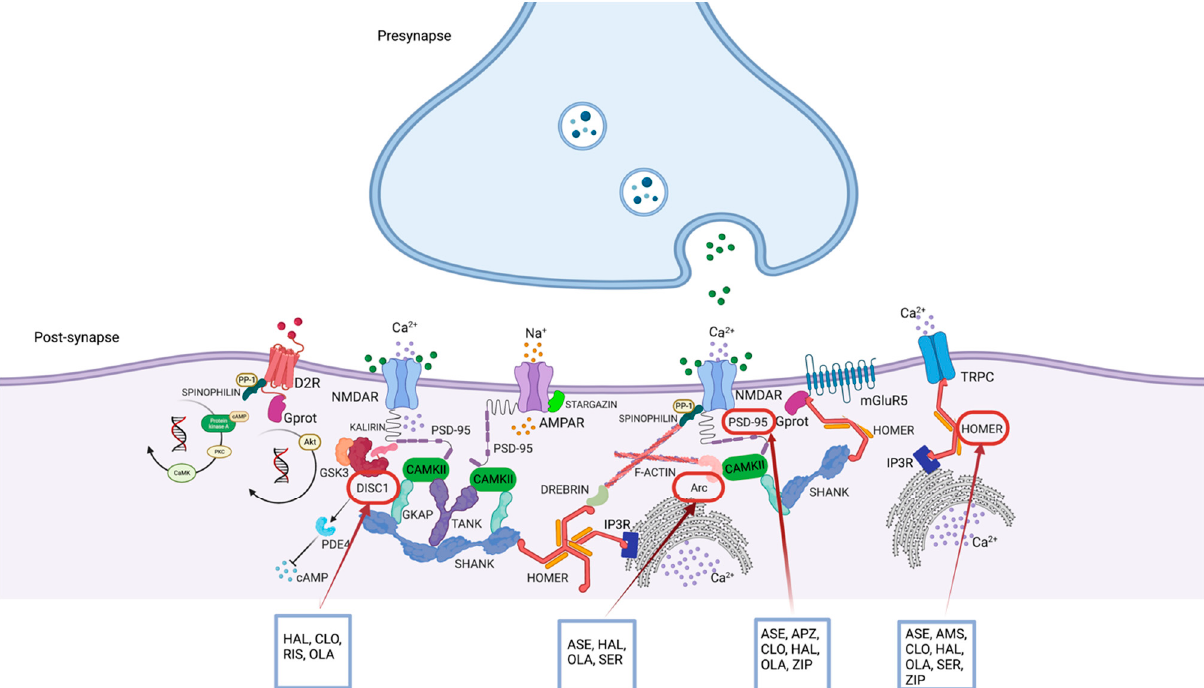
Figure 3. Main PSD proteins modulated by the receptor profile of different classes of antipsychotics. AMPAR = α -amino-3-hydroxy-5-methyl-4-isoxazolepropionic acid receptor; CAMKII = Calcium– calmodulin (CaM)-dependent protein kinase II; F-ACTIN = filamentous actin; GKAP = guanylate kinase-associated protein; GSK3 = Glycogen Synthase Kinase 3 Beta; IP3R = IP3 (inositol 1,4,5- trisphosphate) receptor; mGluR5 = metabotropic glutamate receptor 5; NMDAR = N-Methyl-D- aspartic acid receptor; SHANK = SH3 and multiple ankyrin repeat domains; TANK = TRAF Family Member Associated NFKB Activator; PP-1 = protein phosphatase 1; D2R = dopamine receptor D2; Gprot = G protein; cAMP = cyclic adenosine monophosphate; AKT = protein kinase B; PKC = protein-chinasi C; GSK3 = glycogen synthase kinase-3; Ca2+ = calcium ion; DISC1 = disrupted- in-schizophrenia 1; PDE4 = phosphodiesterase 4A; Na+ = sodium ion; IP3R = inositol 1,4,5- trisphosphate receptor, type 3; TRPC = transient receptor potential cation channel; HAL = haloperidol; CLO = clozapine; RIS = risperidone; OLA = olanzapine; SER = sertindole; ZIP = ziprasidone; APZ = aripiprazole; AMS = amisulpride; ASE = asenapine. Created with BioRender.com; last access on 30 November 2022.